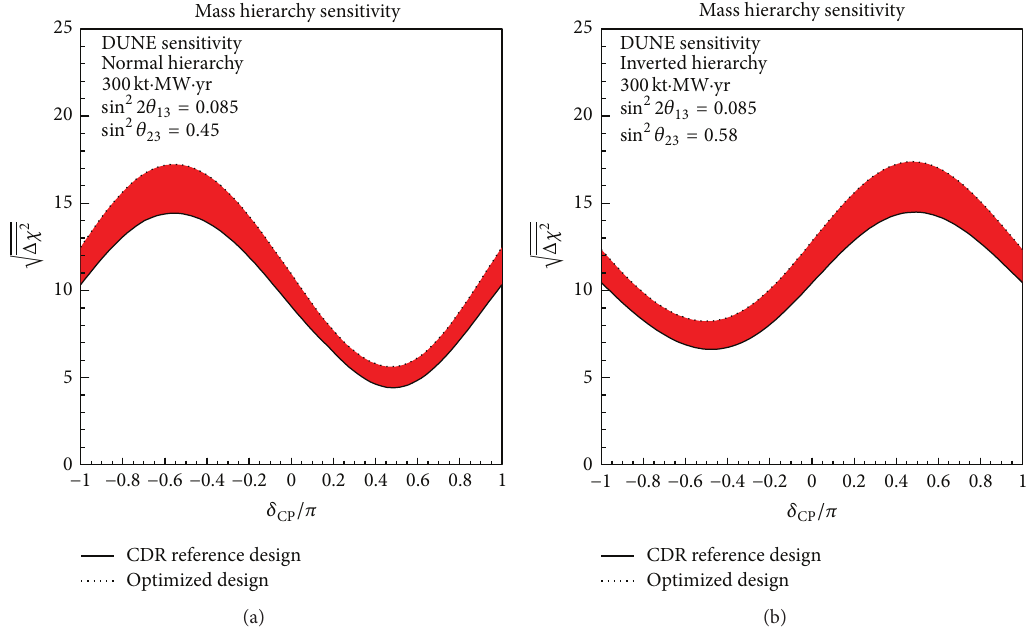
Figure 4: These figures show the sensitivity with which the mass ordering can be determined using the LBNF beam as a function of 𝛿 the NO (a) and IO (b). The shaded region shows the range between the CDR reference design and a possible optimized design of the beam.